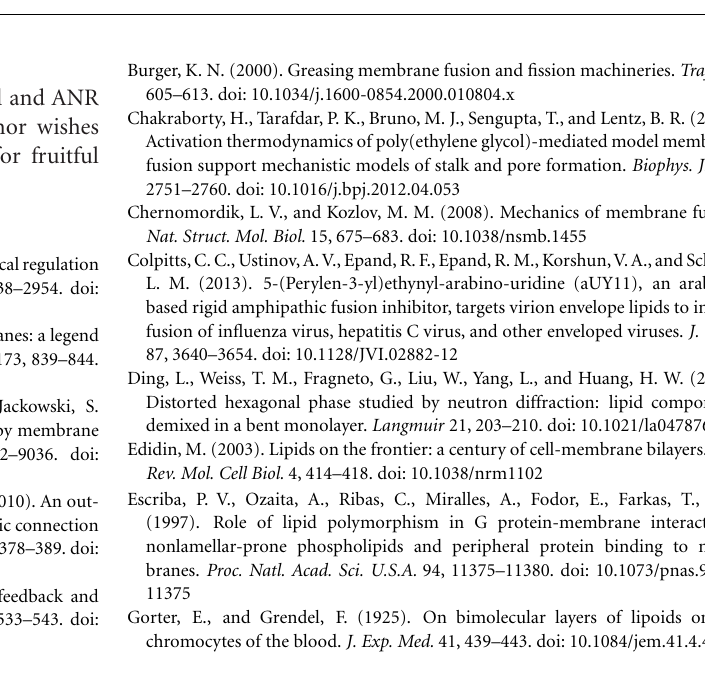
FIGURE 2 | HII phase in bilayers. (A) Lipidic particle as described in (Siegel, 1984). (B) Mechanisms of membrane fusion involving HII via the stalk intermediate. (1) Apposition of two bilayers. (2) Stalk. The stalk is cylindrically symmetrical. (3) Hemifusion intermediate. It can form two different types of structures. If the bilayer diaphragm in the middle of the